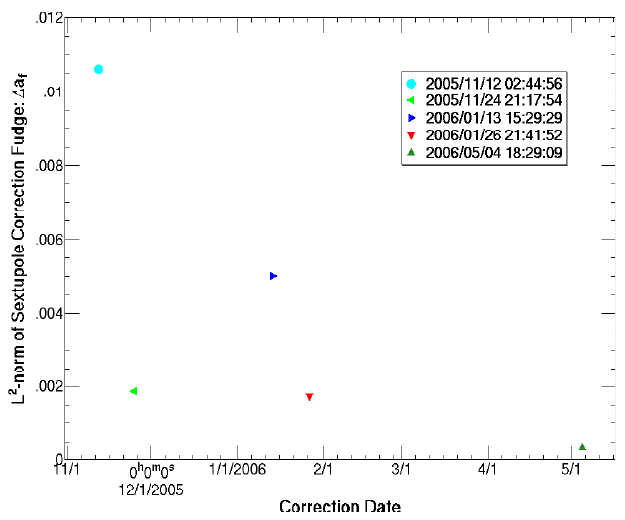
FIG. 5. (Color) Trend of the L 2 -norm of sextupole correction fudge of f . The horizontal axis shows when the off-momentum fudge, 4 a f correction is applied. The vertical axis shows the L 2 -norm of the 4 a distribution in Fig. 4. f